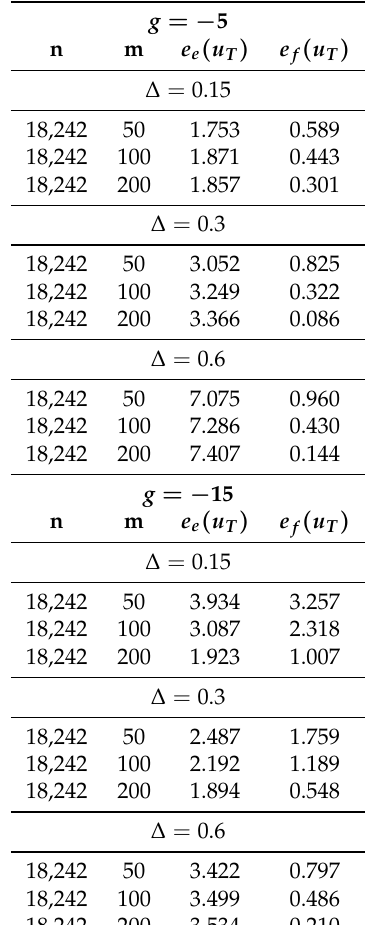
Table 7. Geometry with unstructured grid with delta-smoothing. Relative L 2 error for the temperature at the final time and phase change interface location with respect to the exact solution and a very fine grid solution.